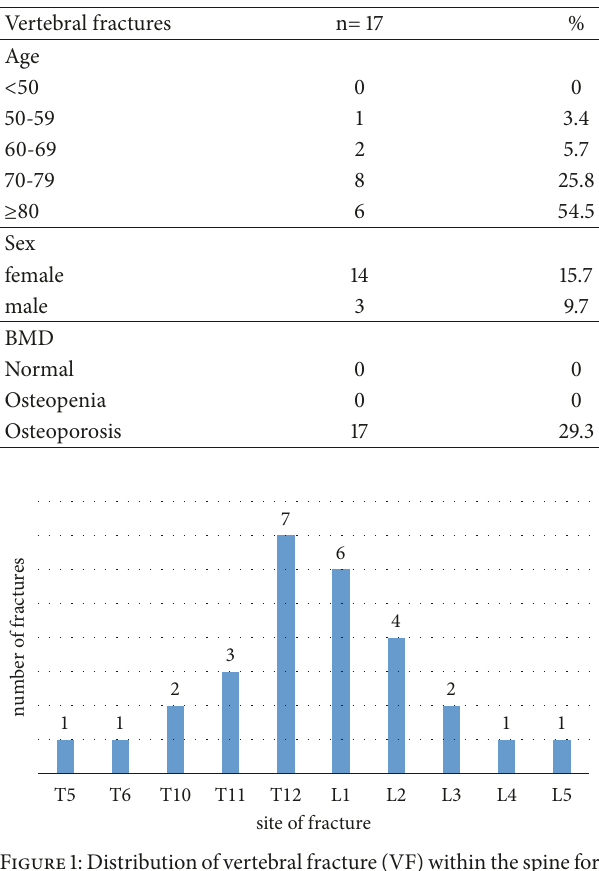
Figure 1: Distribution of vertebral fracture (VF) within the spine for newly referred patients to the osteoporosis clinic.